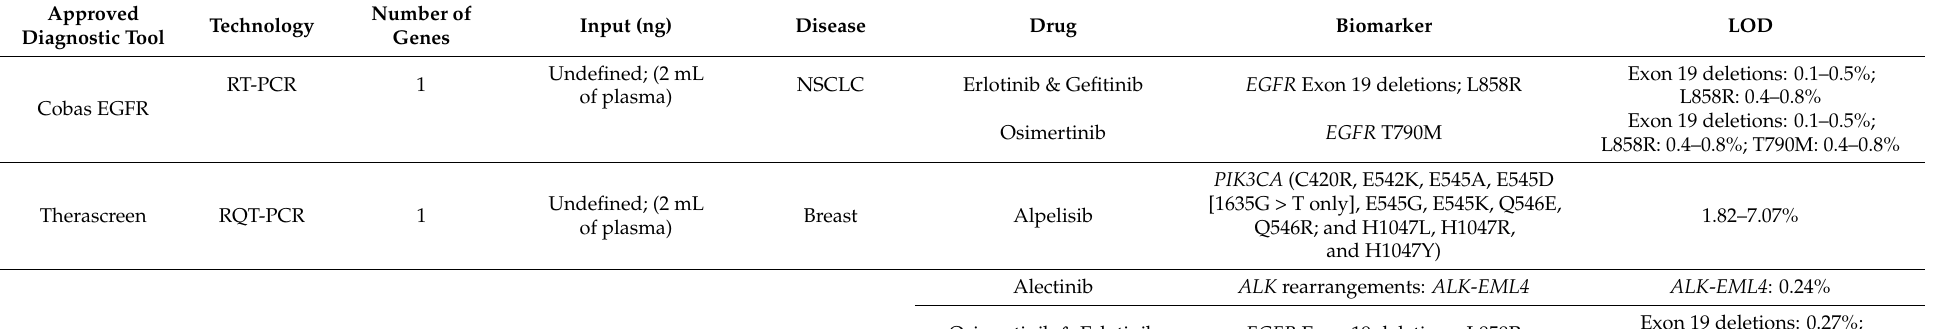
Table 3. Summary of FDA-approved diagnostic plasma ctDNA